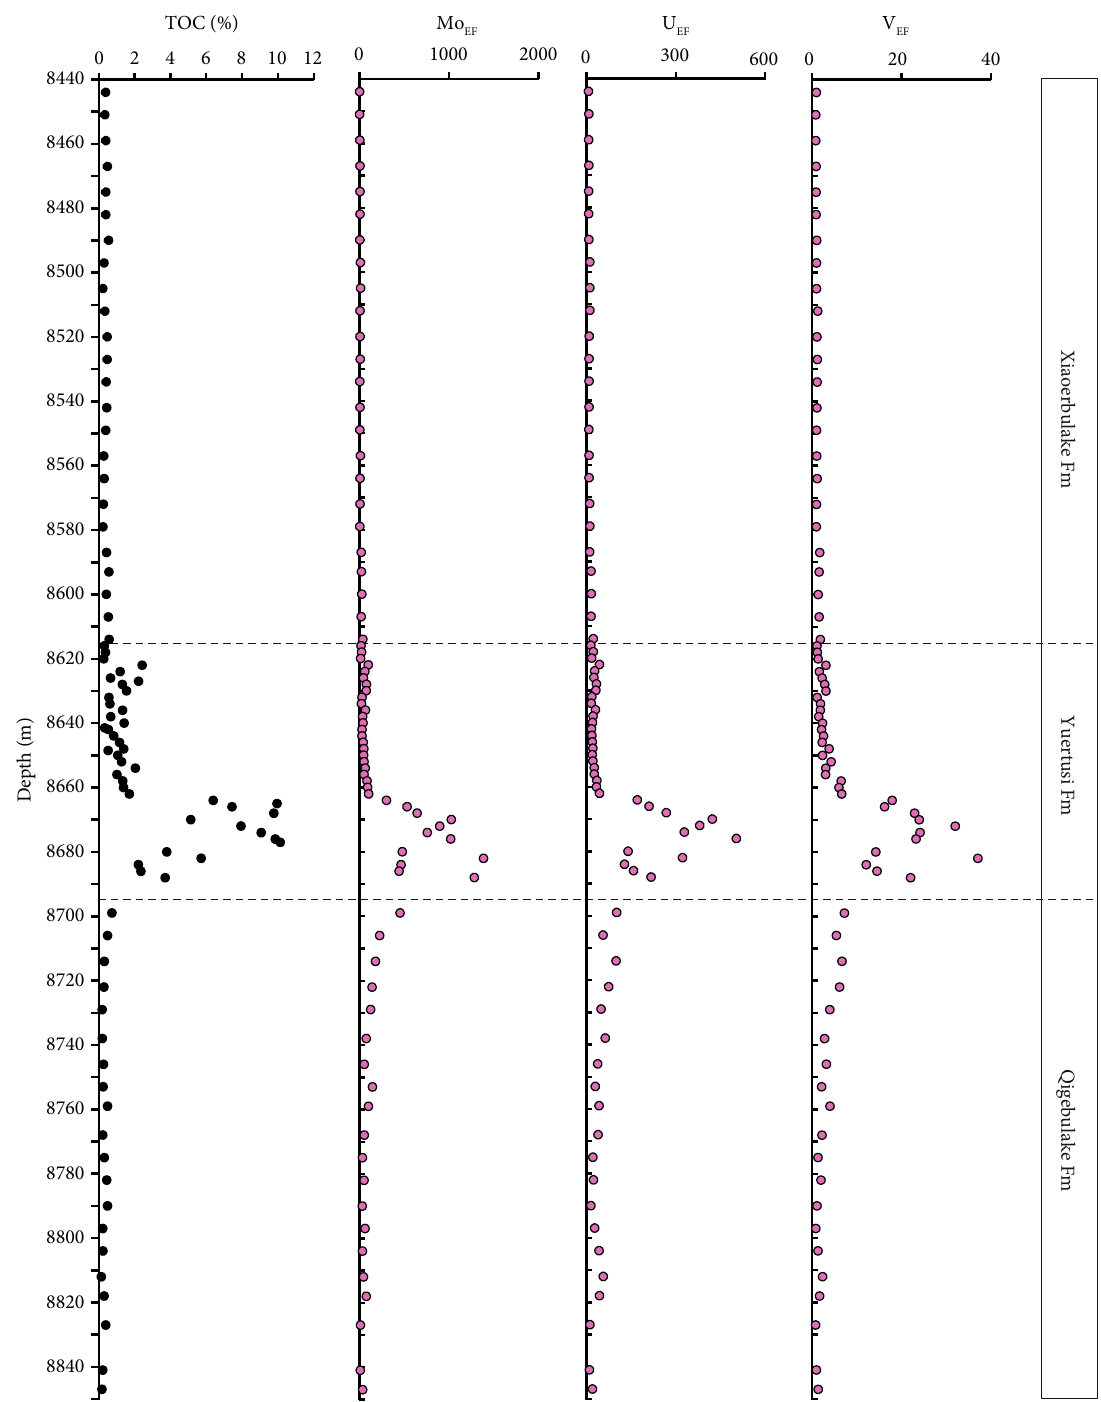
Figure 7: Pro fi les of TOC, Mo